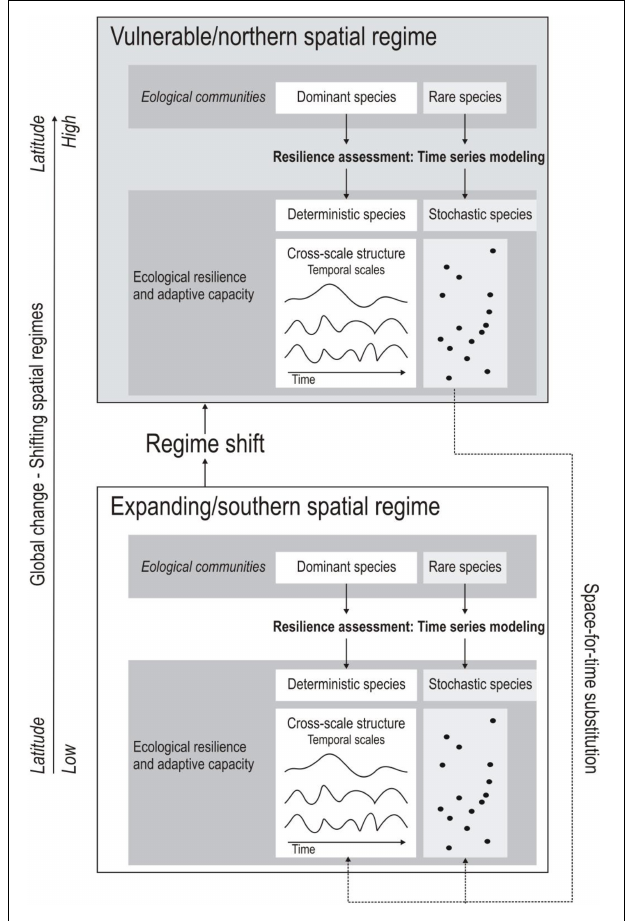
FIGURE 1 | Schematic outlining study design. Time series models using avian communities are used to construct an expanding/southern and vulnerable/northern spatial regime. These regimes account for dominant and rare species with presumably deterministic (symbolized with 3 examples of groups of birds showing similar scale-specific fluctuation frequencies) and stochastic patterns (represented by dots symbolizing species) in the models. The relevance of stochastic species of the northern regime to become deterministic or stochastic once it has been encroached by the southern regime will be